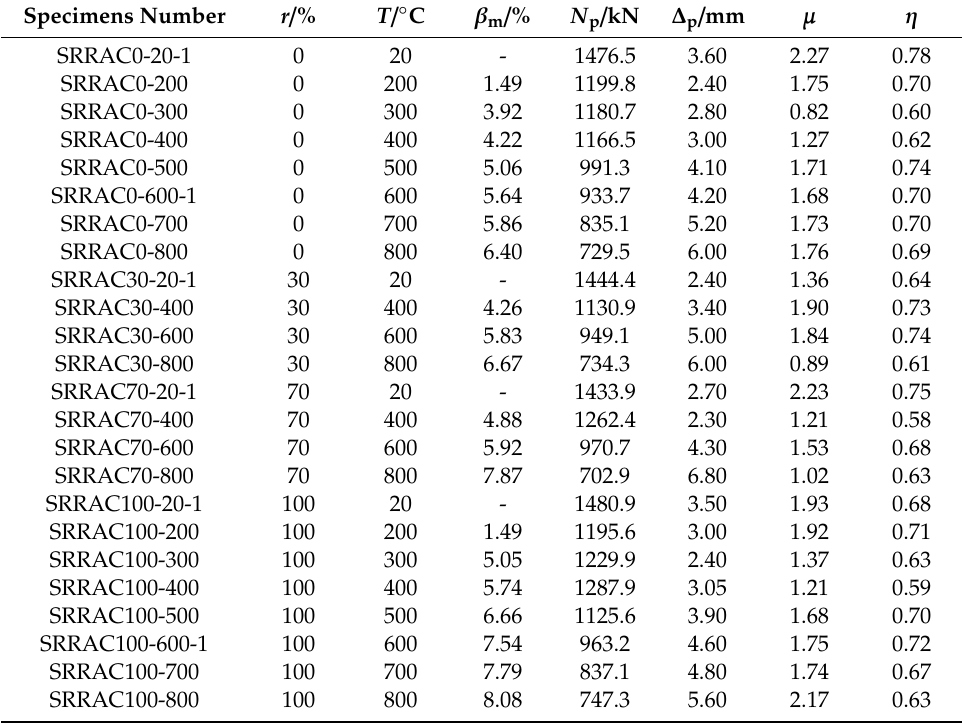
Table 3. Design parameters and experimental results of steel reinforced recycled aggregate concrete (SRRAC) columns.